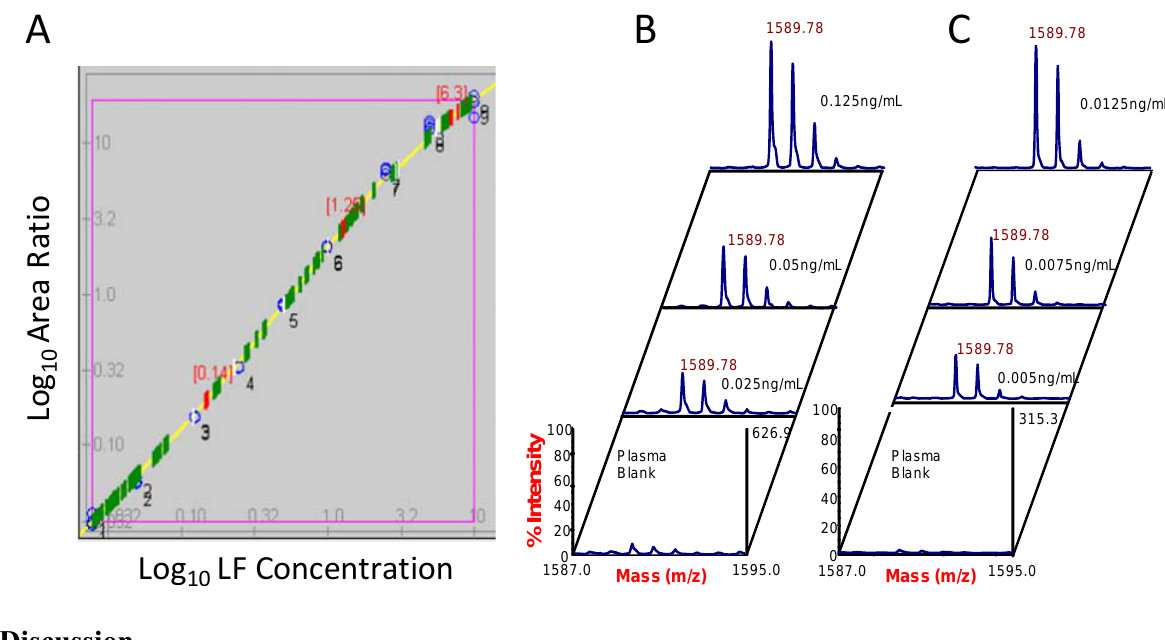
Figure 8. Standard curve for the low volume (20 µL) overnight incubation for standards ranging from 0.025 ng/mL to 10 ng/mL LF spiked in plasma, captured by LF mAbs on magnetic beads, and incubated with substrate LF-5, analyzed by MALDI-TOF MS, and CT-5 peaks quantified as described previously[6,7] (A). Spectra are shown with the X-axis narrowed on CT-5 LF hydrolysis product peak for high volume (200 µL) of LF standards; 0.125 ng/mL, 0.05 ng/mL, 0.025 ng/mL, and plasma blank control for 2 h reaction (B) and for 0.0125 ng/mL, 0.0075 ng/mL, and 0.005 ng/mL for the extended incubation